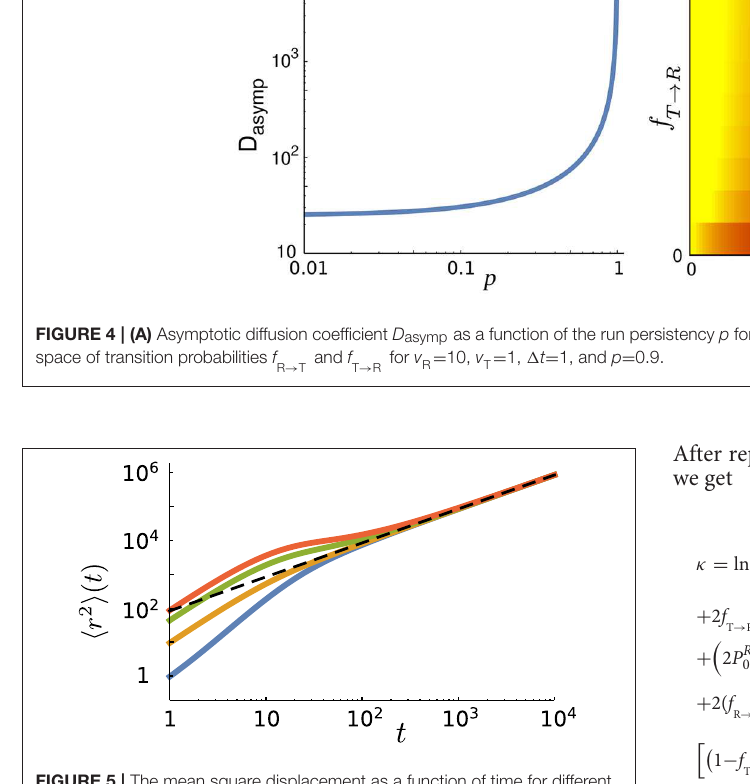
FIGURE 5 | The mean square displacement as a function of time for different values of the probability P R 0 of initially starting in the run state in simulations (from top to bottom: P R 0 = 1.0,0.5,0.1,0.0). Other parameter values: p = 0.9, = 0.1, and f = 0.01. The dashed line represents the v R = 10, v T = 0.1, f R → T T → R analytical prediction via Equation (17) for the same parameter values.